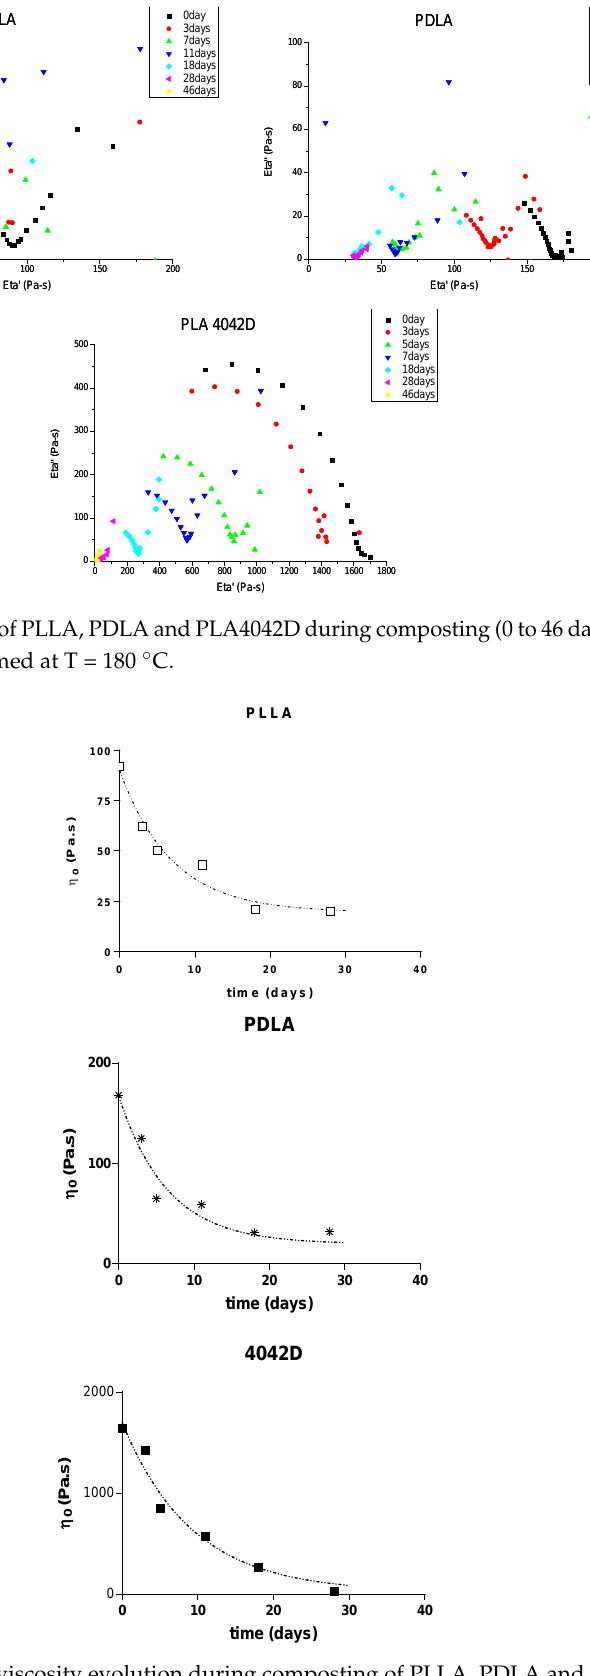
samples (k = 0.12 − 0.15 day − 1 ) (R 2 = 0.9658 (PLLA), 0.9383 (PDLA), 0.9666 (4042D)). The good